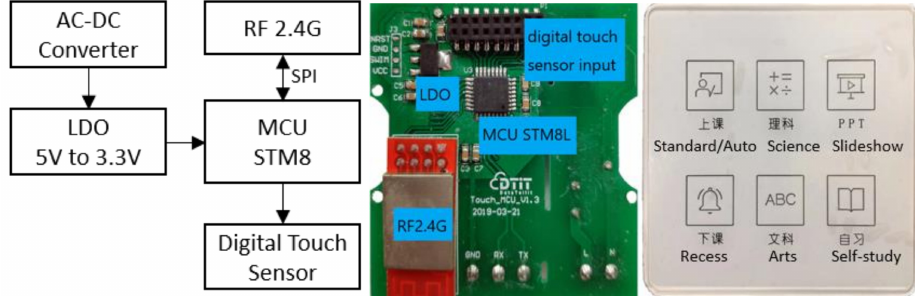
Figure 6. Control panel block diagram, working board, and front